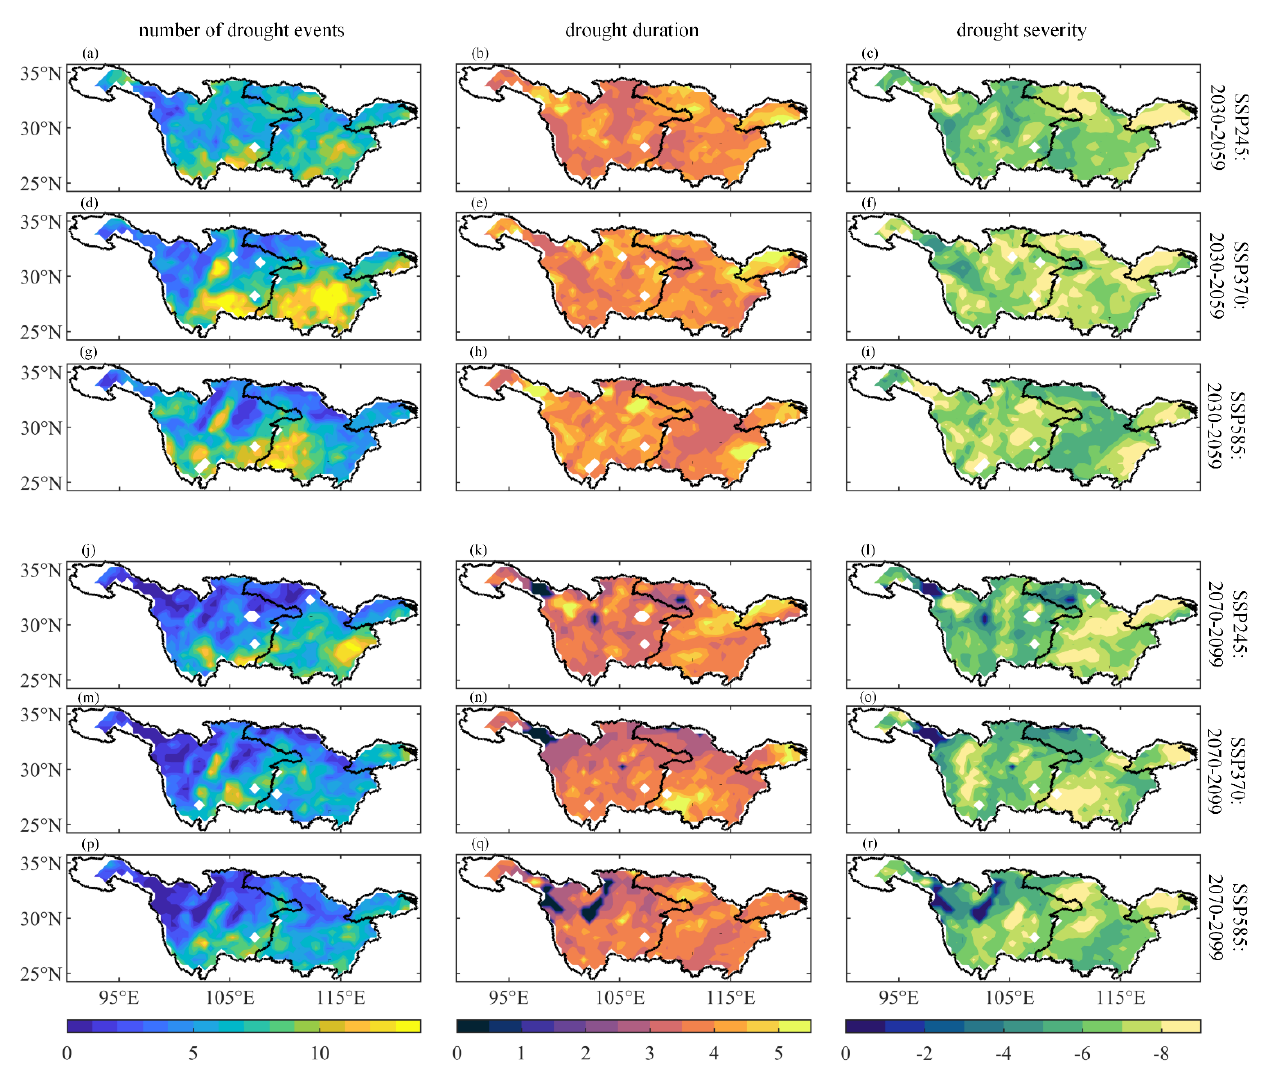
Figure 5. Spatial distribution of the number of drought events ( a , d , g , j , m , p ), average duration ( b , e , h , k , n , q ), and average severity ( c , f , i , l , o , r ) in the 3-month scale in the Yangtze River basin